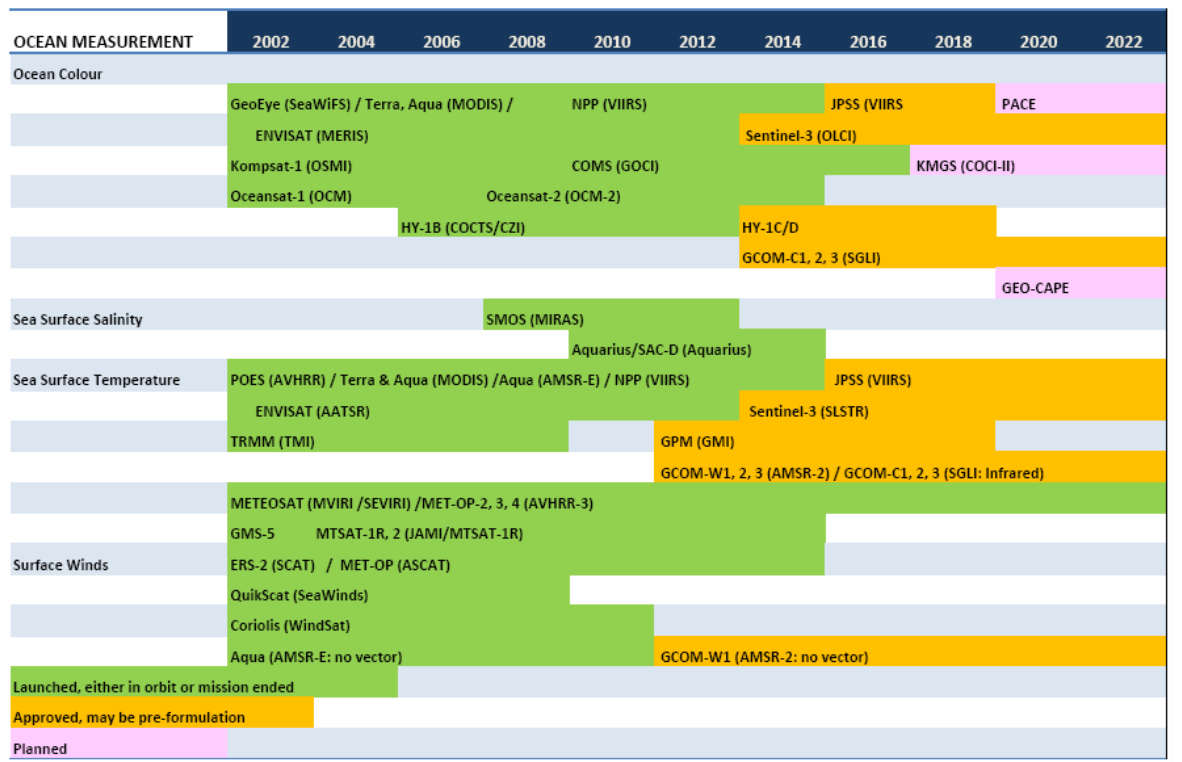
Figure 7. Satellite missions ongoing and planned. (A) Ffor XCO 2 and XCH 4 column mixing ratio observations with PBL sensitivity; launched or near-launched (green), approved – maybe at pre-formulation stage (tan), and planned missions (pink). Outlined dashed black are active sensors (lidar). (B) Same for ocean carbon-cycle satellite missions. (C) Same for terrestrial carbon